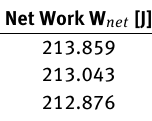
Consequently, it is observed in Fig. 7 the net work of the Szorenyi rotary engine is the greatest per working cy- cle, followed by the Wankel rotary engine and finally the reciprocating engine as summarised in Table 2.